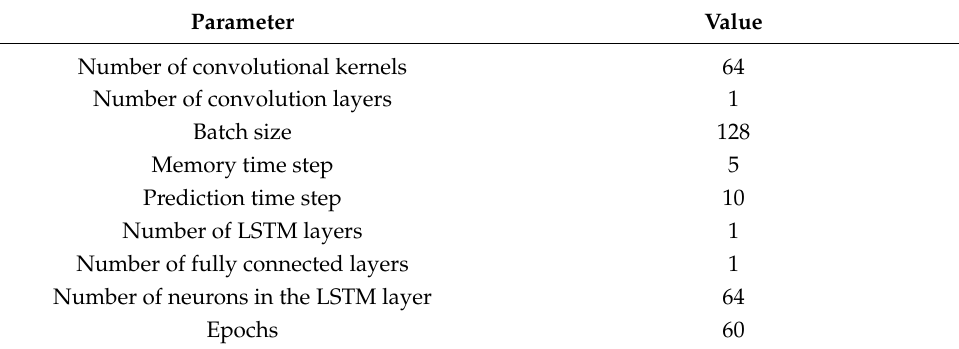
Table 3. Parameters of the CNN-LSTM car-following model.